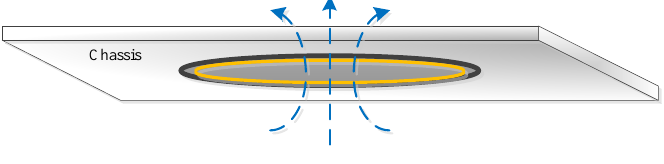
Figure 1. Sketch of EV